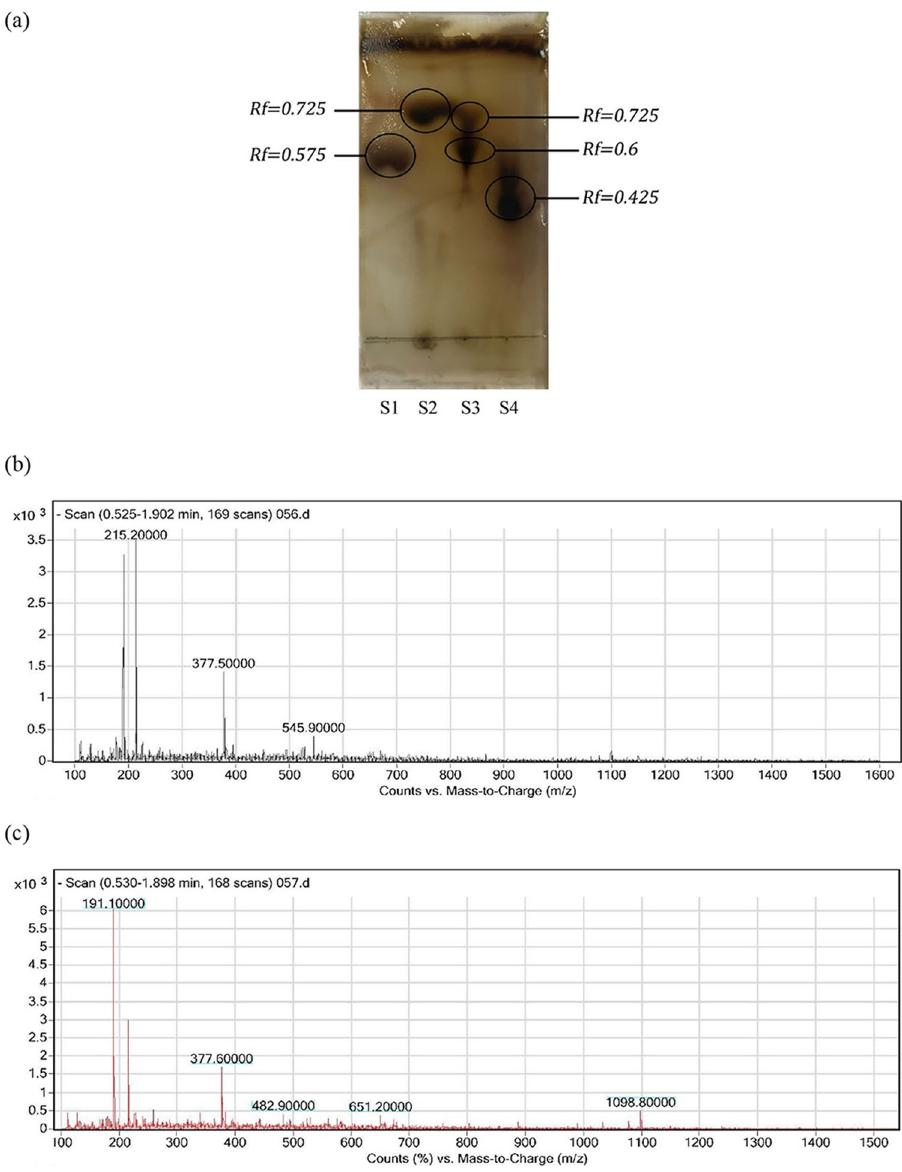
Figure 3. ( a ) TLC assessment patterns of samples obtained from the pectinolytic activity of isolates, S1: standard solution of glucose, S2: pectic oligosaccharide obtained from A. faecalis AGS3, S3: pectic oligosaccharide obtained from P. polymyxa S4, S4: standard solution of mono-galacturonic acid; LC–ESI–MS mass spectrums of samples obtained from pectin degradation by ( b ) A. faecalis AGS3, and ( c ) P. polymyxa